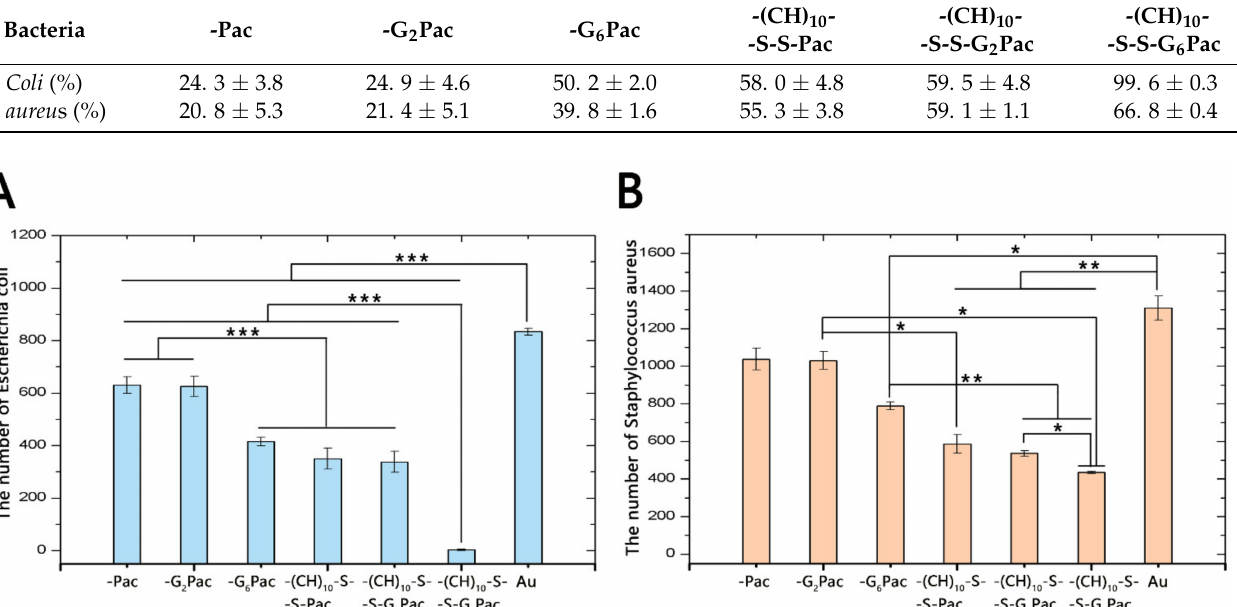
Table 3. The inhibitory ratios of different substrates.